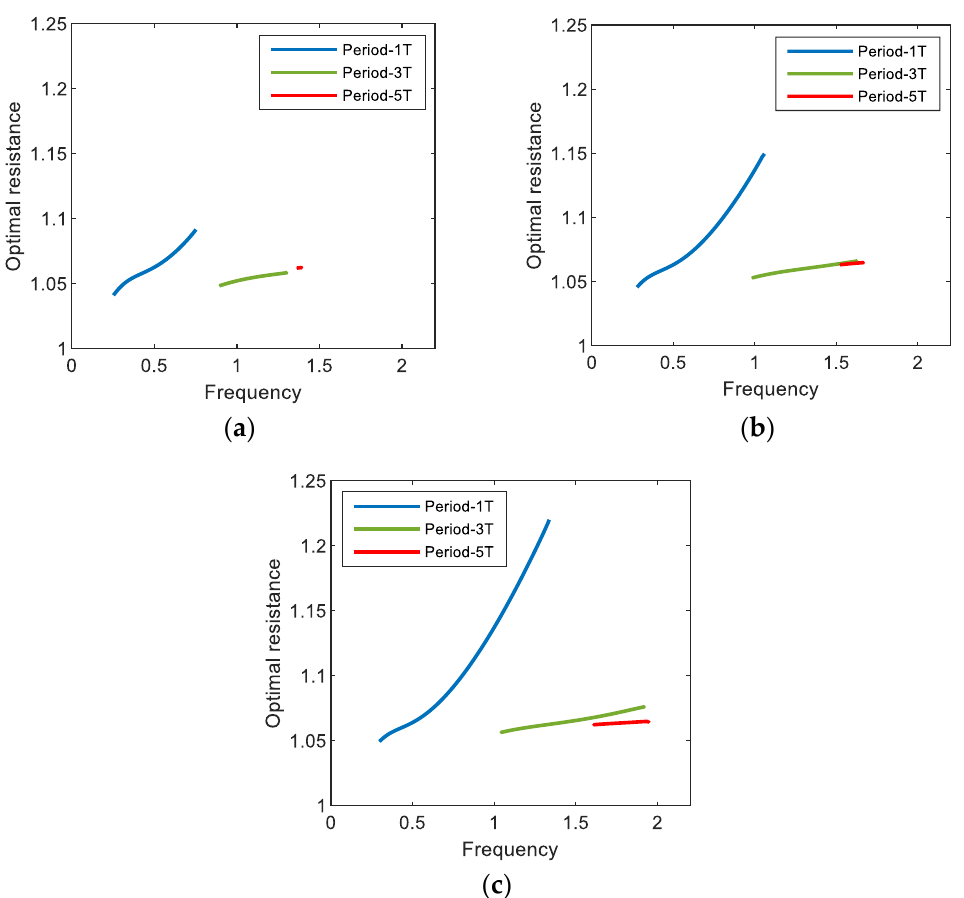
Figure 9. Plots of the excitation frequency versus the optimal load resistance for the interwell motions (with periods 1 T , 3 T , and 5 T ) of the electromagnetic energy harvester. In this simulation, the acceleration of base excitation is set to ( a ) 0.012, ( b ) 0.02, and ( c ) 0.03.